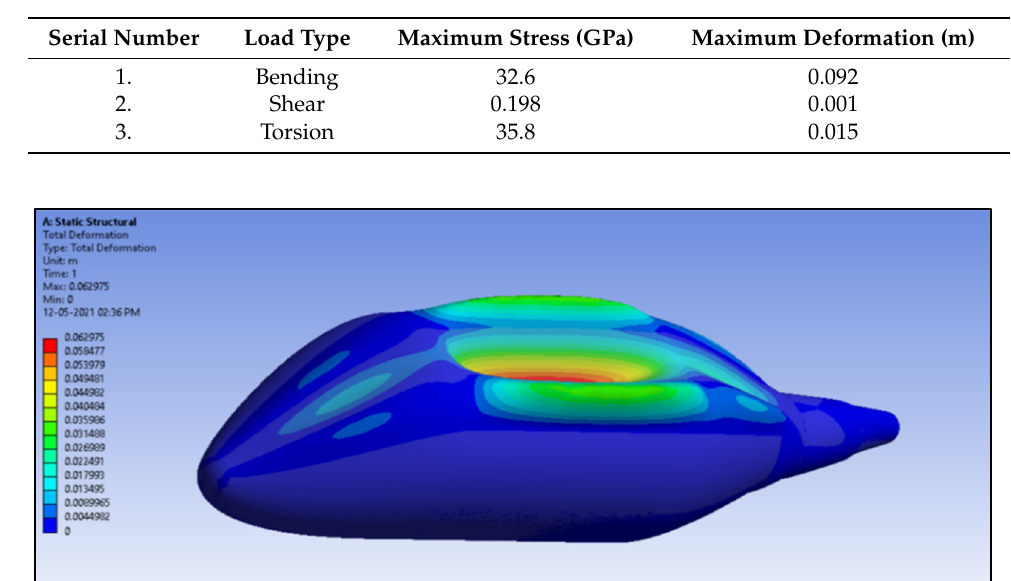
Figure 32. Deformation of fuselage subjected to 100 kN bending load.